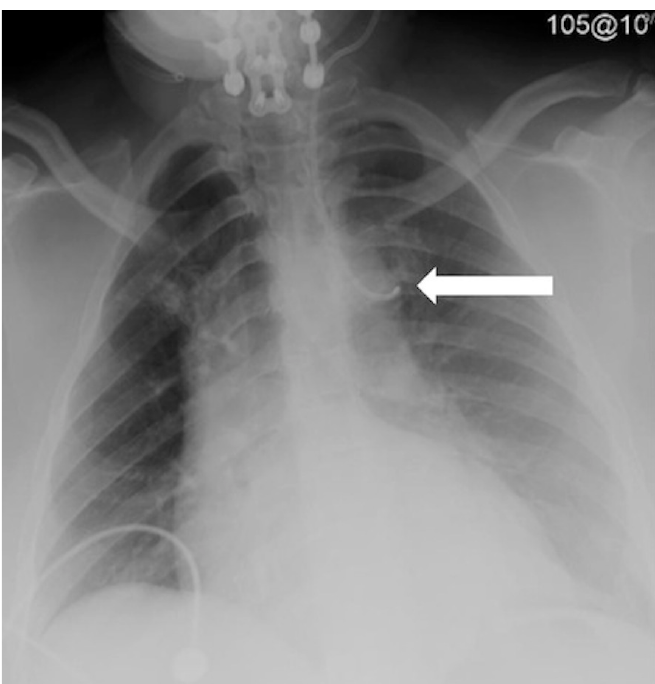
Figure 4. Portable chest radiography, limited by the patient’s body habitus, showing bilateral retrocardiac opacities and mild cardiomegaly. A left internal jugular central venous catheter extends through the hemiazygos vein; the catheter tip is most likely located in a left intercostal vein (arrow). A chart review revealed that the same malpositioning was present two months earlier. The patient experienced burning pain in the chest during a crystalloid bolus